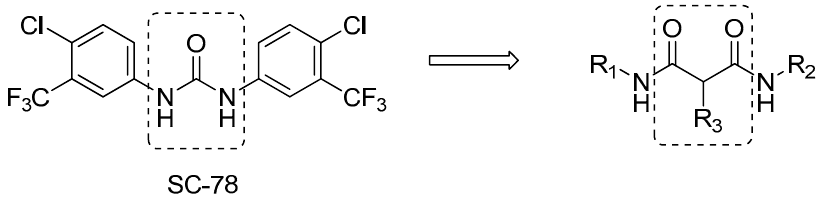
Figure 1. Chemical structure of SC-78 and scaffold of malonate derivatives.